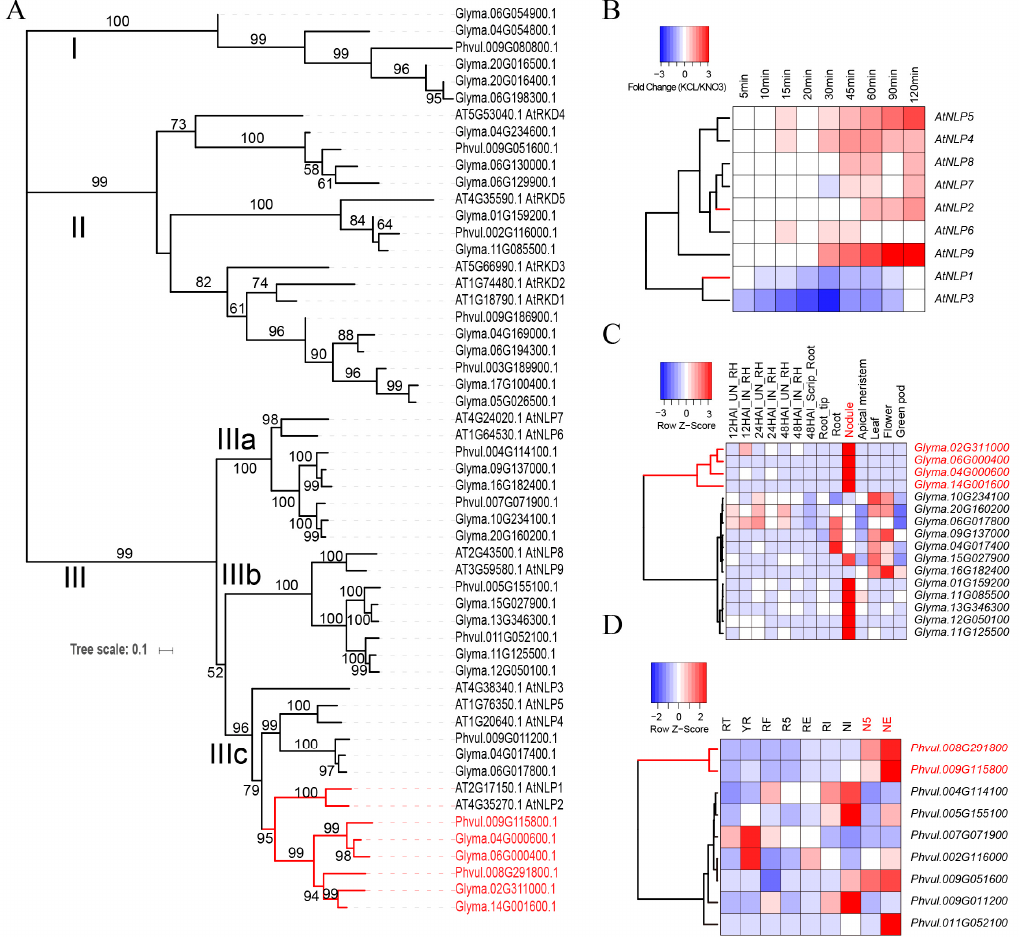
Figure 3. Phylogeny and comparison of RWP-RK expression patterns among Arabidopsis thaliana , Phaseolus vulgaris , and Glycine max . ( A ) Gene tree of RWP-RK proteins with bootstrap values ranging from 50 to 100 on each branch. ( B ) Fold changes of RWP-RKs in comparison of N-starvation roots (KCl treatment) to N-supplementation roots (KNO 3 treatment) of A . thaliana . ( C ) Expression pattern of RWP-RKs in multiple tissues of G . max. 12HA1_IN_RH, 12HA1_UN_RH, 24HA1_IN_RH, 24HA1_UN_RH, 48HA1_IN_RH, 48HA1_UN_RH, 48HA1_Scrip_Root represent root hairs (RH), and stripped roots inoculated (IN) and mock-inoculated (UN) with B. japonicum at 12, 24, and 48 HAI (hours after inoculation); 18-day-old root tip, root and leaf, 18-day-old apical meristem, flower from R2 stage, green pod from R6 stage, nodule harvested 32 days after the inoculation. ( D ) Expression pattern of multiple tissues in P. vulgaris . RWP-RKs with high expression patterns in nodules were marked with red. In P. vulgaris , RT, root tips collected from fertilized plants; YR, whole roots, including root tips; RF, whole roots from fertilized plants; R5, whole roots separated from 5 day old pre-fixing nodules; RE, whole roots separated from effective nitrogen-fixing root nodules (NFN) collected 21 days after inoculation (DAI); RI, whole roots separated from ineffective NFN collected 21 DAI, NI, ineffective NFN collected 21 DAI; N5, effective pre-fixing nodules 5 DAI; NE, effective NFN 21 DAI. 2.4. The Involved Biological Processes of AtNLPs-Associated Modules under N starvation Condition Despite the important roles of nitrates in plant growth, N limitation, including N starvation or low N, is essential for nodulation in legumes [11]. To investigate the possible relationship between N starvation and nodulation, we explored differences in the modules containing different AtNLPs under N starvation vs. N supplementation. We used WGCNA (weighted correlation network analysis) to construct a weighted network from N-starvation datasets with rlog normalization (Figure